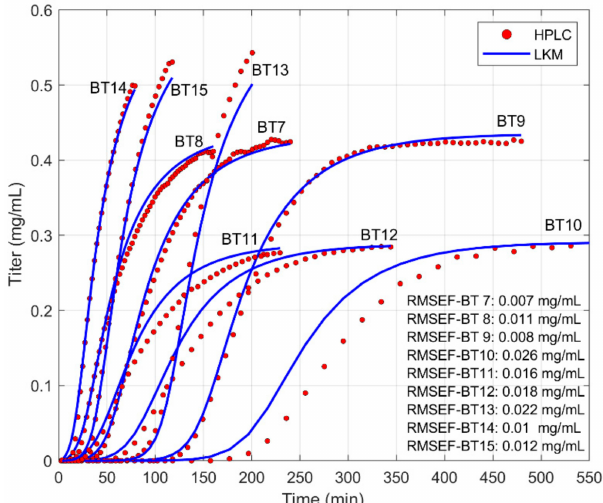
Figure 5. Internal mechanistic model (LKM) predictions of titer for BT#7–15 (blue) and corresponding HPLC o ff -line measurements